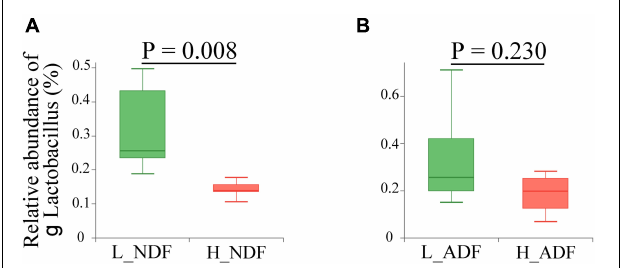
FIGURE 2 | Comparison of the relative abundance of genus Lactobacillus between high and low apparent fiber digestibility. The relative abundance difference of genus Lactobacillus were compared between H_NDF and L_NDF groups ( A , P < 0.01), and H_ADF and L_ADF groups ( B , P > 0.05) by Wilcoxon rank-sum test,